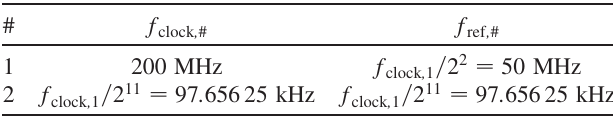
TABLE I. Clock and reference signal frequencies.